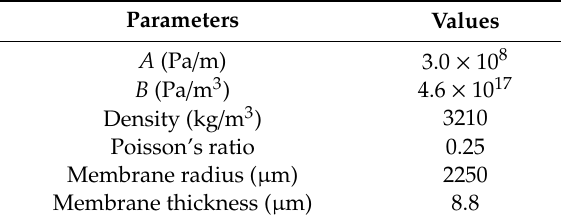
Table 2. Parameters used for both bulge test and finite element method (FEM)